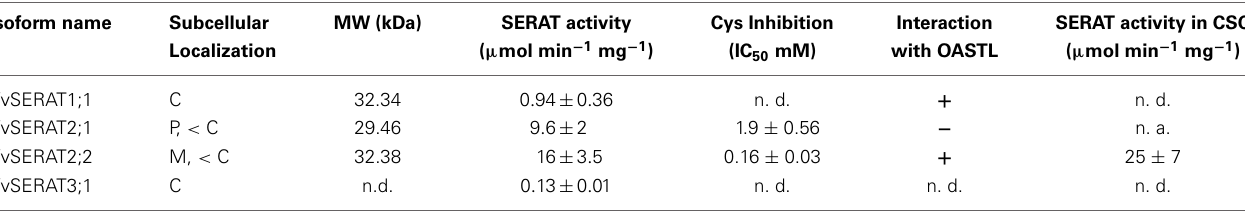
Table 1 | Subcellular localization and biochemical properties of SERAT proteins in grapevine.